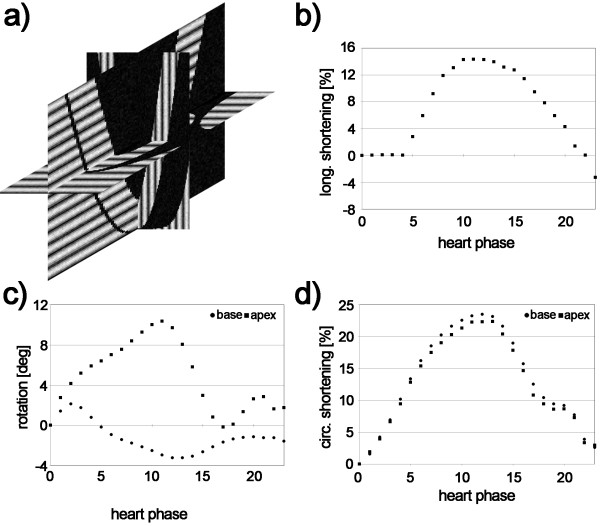
Numerical simulation. Three stacks with orthogonal line tag pattern were simulated (a). As input for the model, longitudinal shortening (b), rotation (c) and circumferential shortening (d) obtained from one in-vivo acquisition were used.